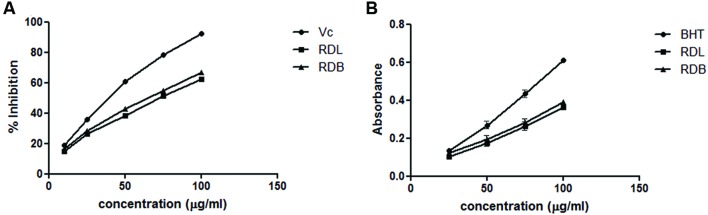
(A) 1,1-Diphenyl-2-picrylhydrazyl (DPPH) radicle scavenging assay of methanol extract of RD leaf and bark extracts: (RDL), RD leaf extract; (RDB), RD bark extract; (Vc), ascorbic acid. (B) Reducing power activity of methanol extract of RD leaf and bark extracts: RDL, RD leaf extract; RDB, RD bark extract; BHT, butylated hydroxytoluene.